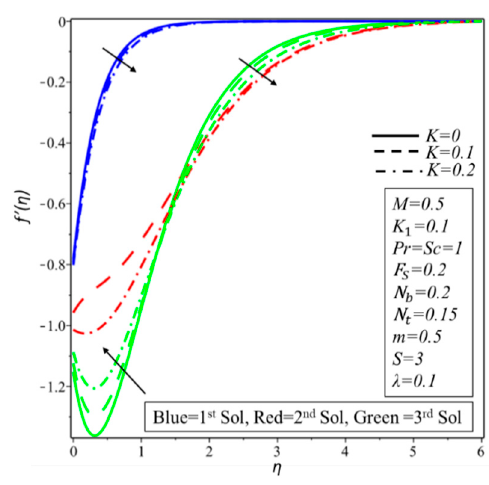
Figure 2. Profiles of the velocity for increasing values of K .